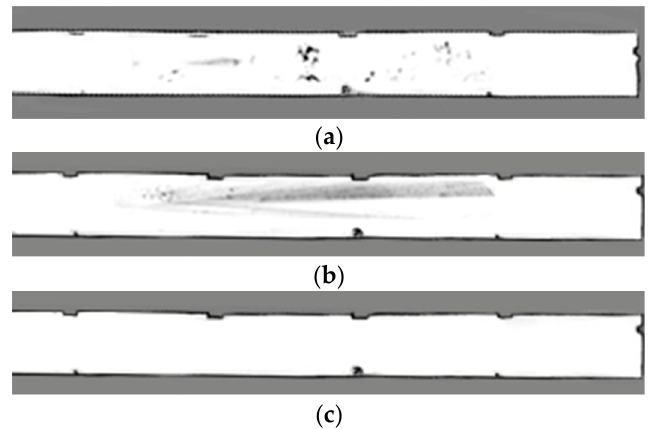
Figure 7. Maps built in open-loop scene (inside the corridor area, the darker the area was, the more blurry it was, that is, the lower quality it will be). ( a ) A map built with Cartographer with LiDAR only; ( b ) a map built with Cartographer with LiDAR+IMU fusion; ( c ) a map built with the proposed method.